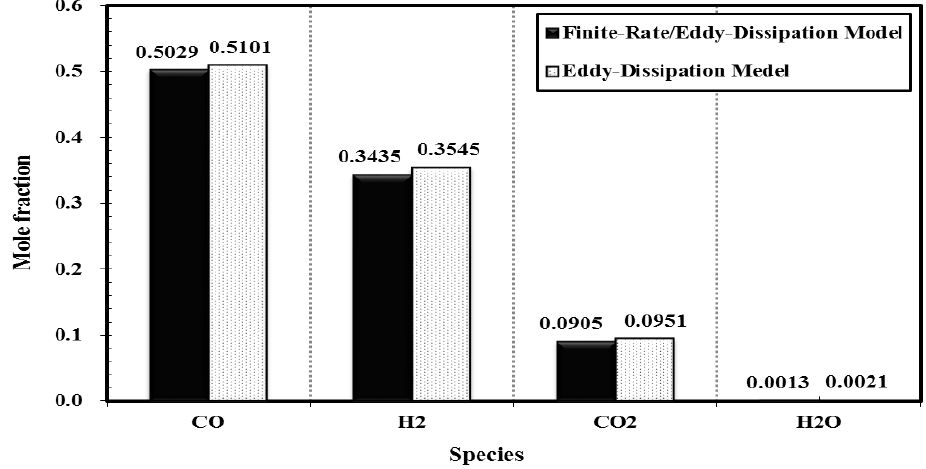
Figure 5. Effect of gas-phase chemical reactions on product